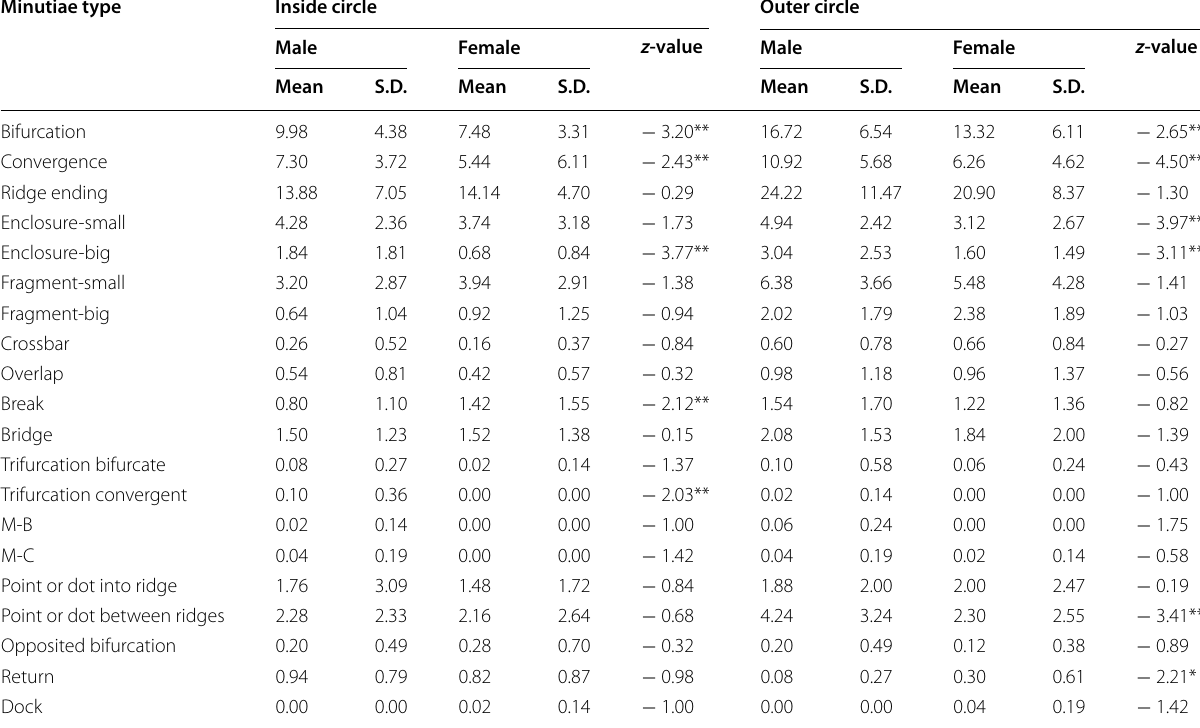
Level of significance p < 0.01**, p < 0.05*